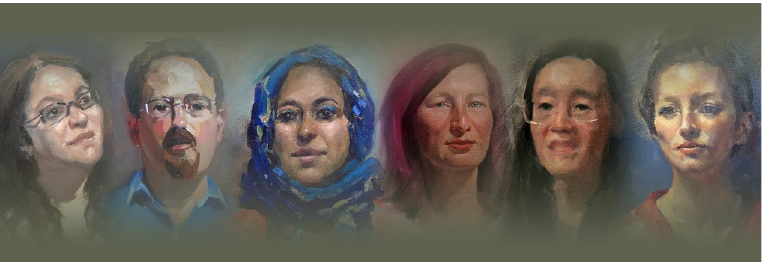
Fig 1. Viewing the Invisible project banner featuring portraits left to right of Naomi Alderman, Julian Huppert, Misbah Arif, Rivka Isaacson, Chun-wa Chung, and Megan Dowie. ( Image : acapmedia ).